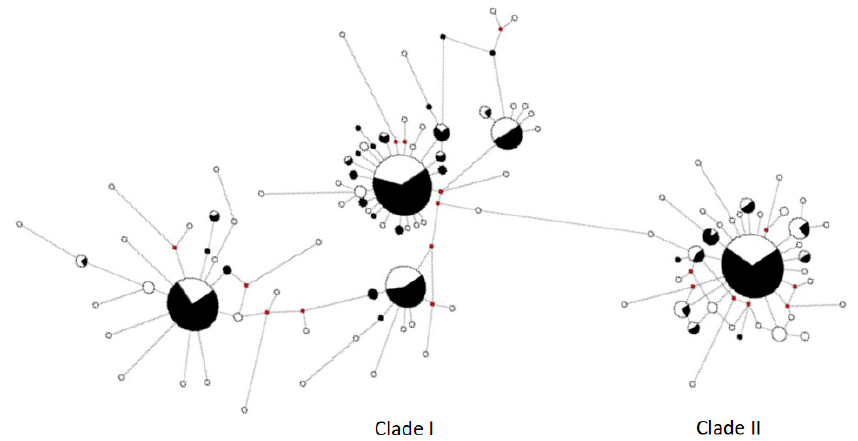
Figure 2. MJ network for the complete dataset of Mediterranean swordfish. White slices indicate haplotype observed by Viñas [17] and black slices recent sample (this work). Small red circles correspond to missing (or hypothetical) haplotypes.